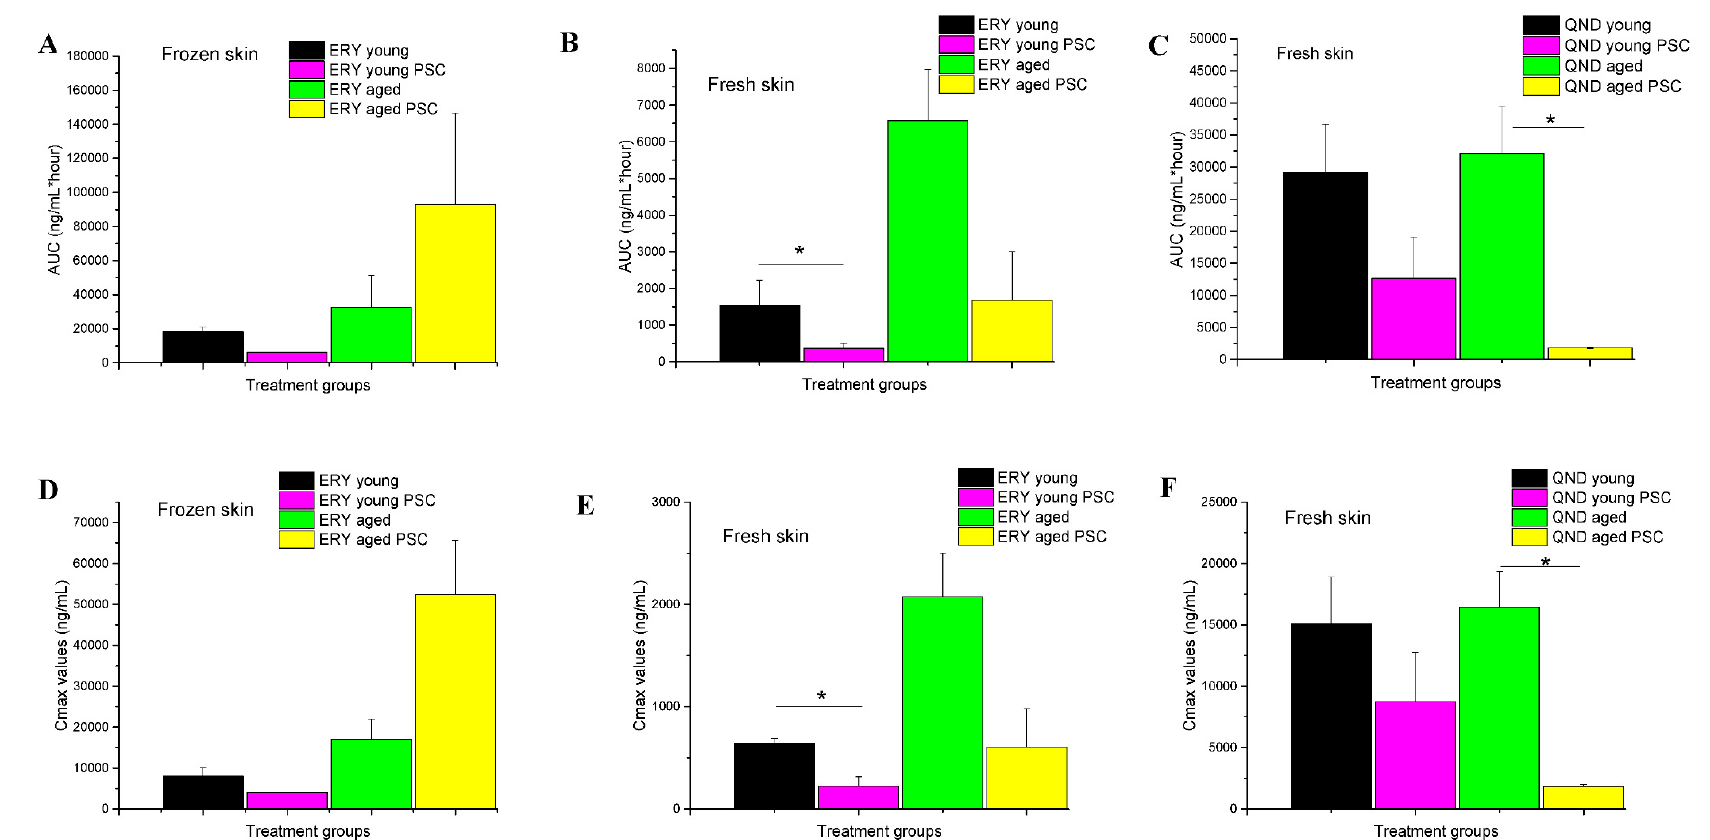
Figure 5. Ex vivo skin penetration of erythromycin (ERY) and quinidine (QND) measured in frozen ( A , D ) and fresh ( B , C , E , F ) rat abdominal skin preparations in the presence or absence of topical PSC-833 (valspodar) pretreatment in Franz diffusion cells. Data are presented as means +/ − SE. n = 3. Y: young rat skin, A: aged rat skin. * p < 0.05 by Student t -test (2,2).